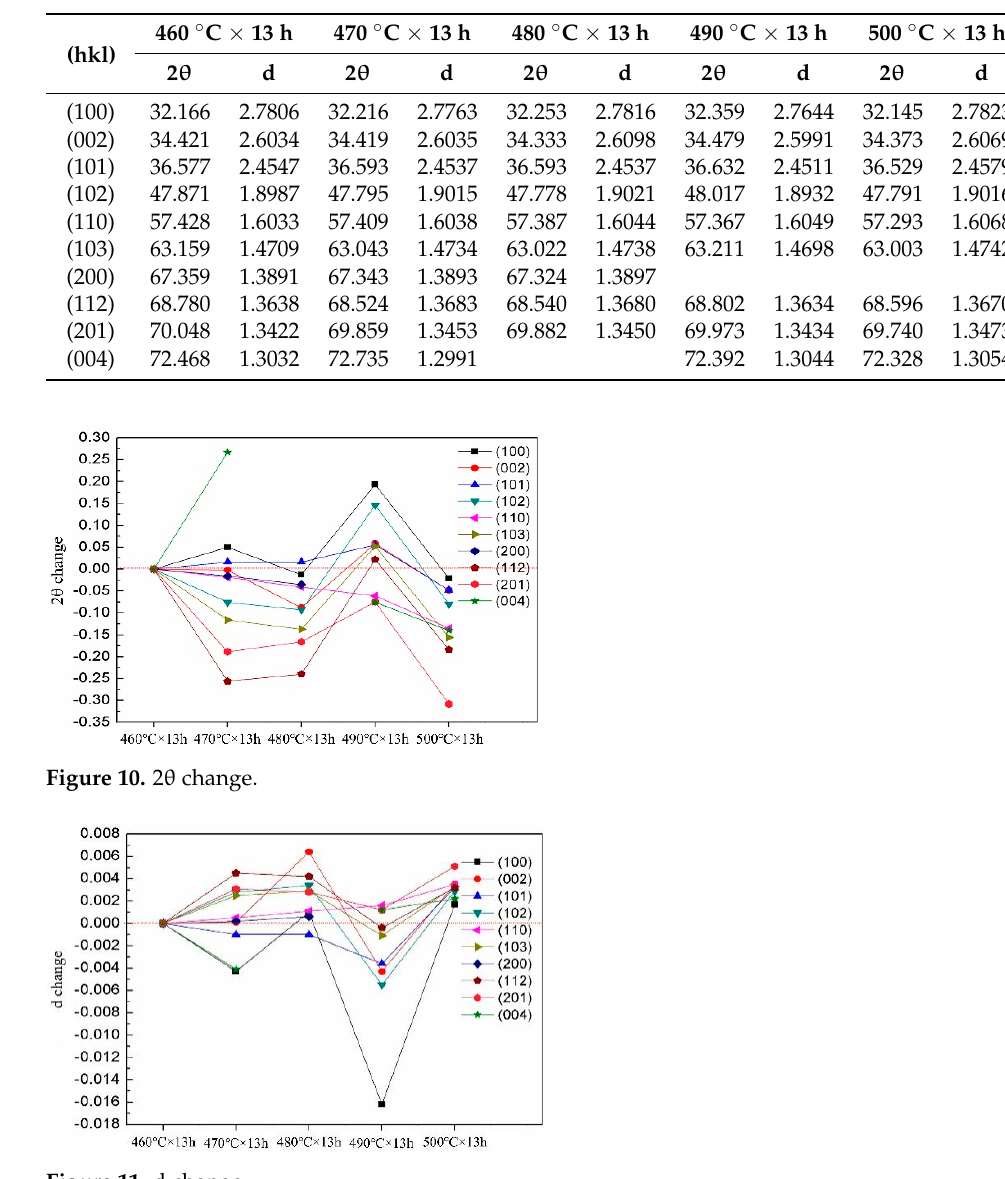
Figure 11. d change.